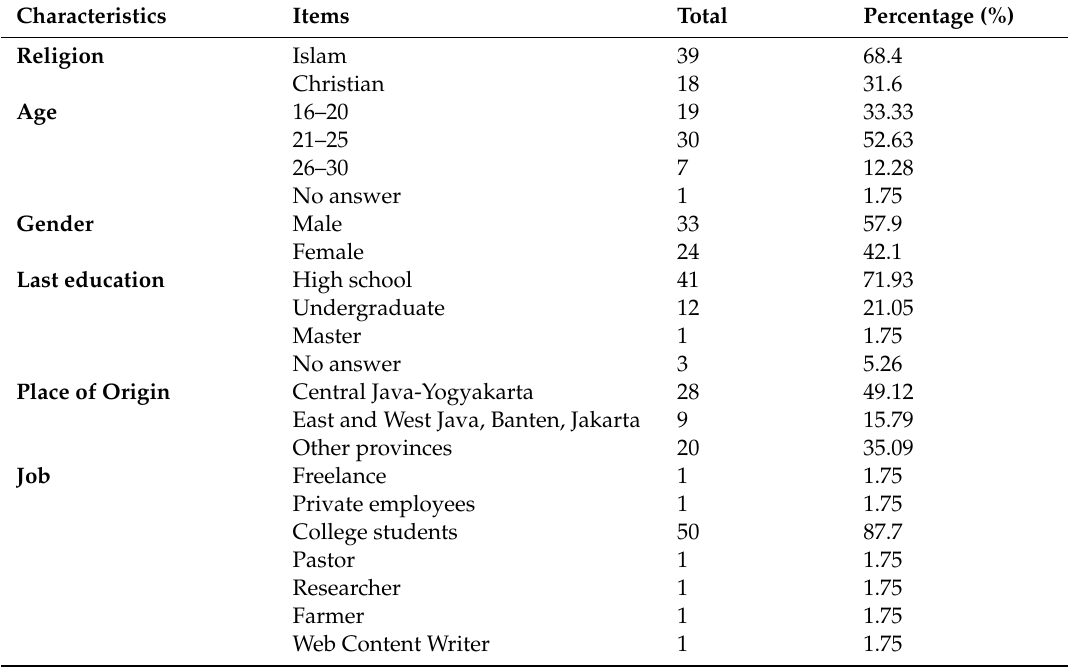
Table 1. Respondent